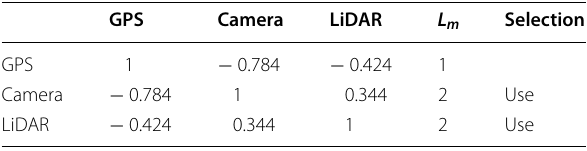
Table 1 Correlation table at 330 s in Fig.